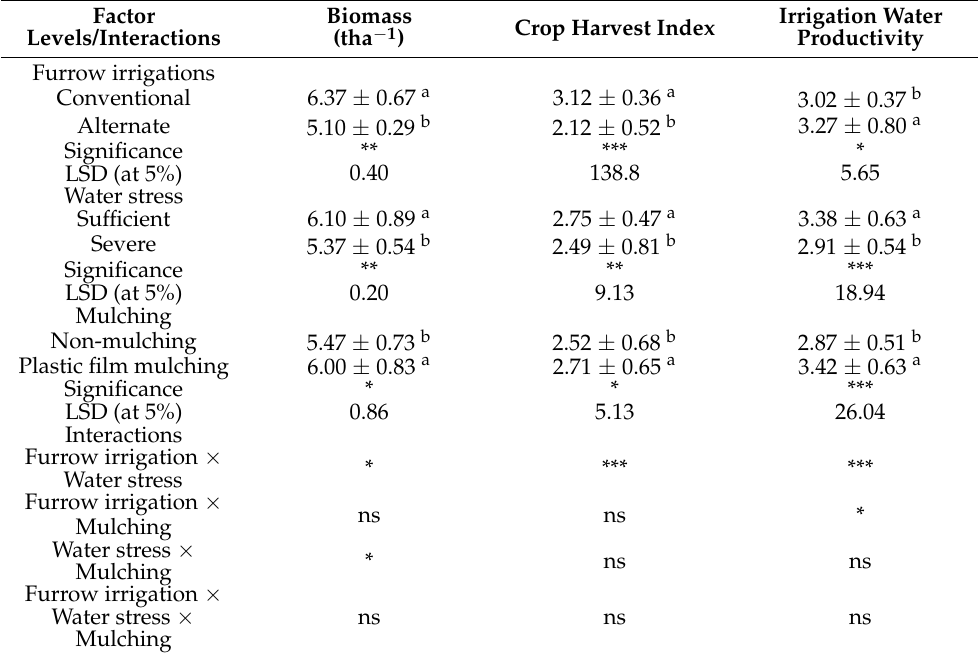
Table 6. Main factor effects and interactions of furrow irrigation method, water stress, and plastic mulching on mean biomass, crop harvest index, and irrigation water